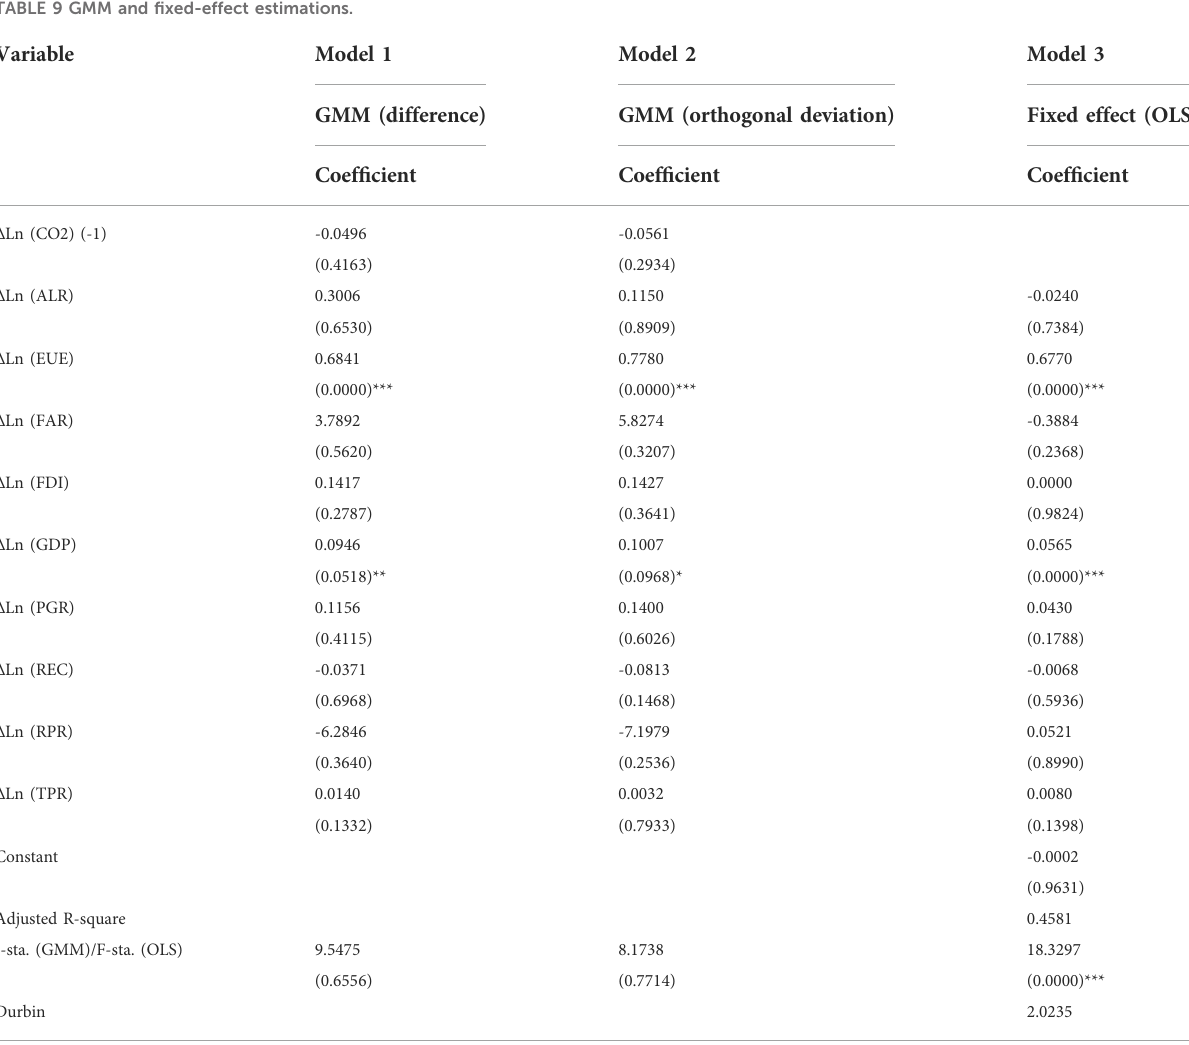
TABLE 9 GMM and fi xed-effect